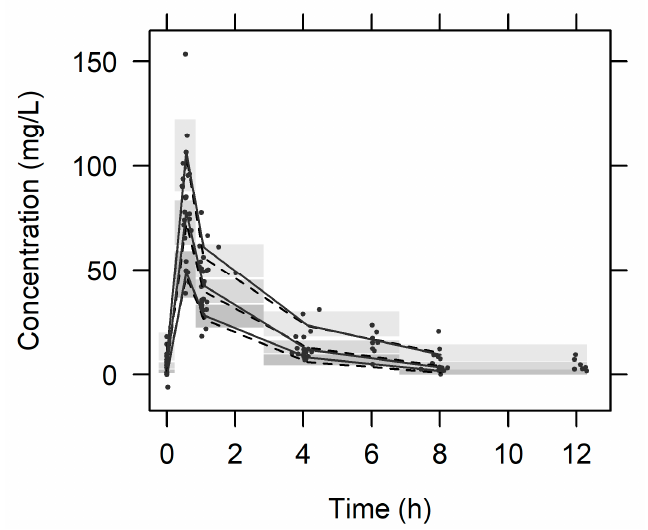
Figure 2. Visual predictive check plot. Plots from virtual concentrations of 1000 simulated datasets. Closed circles, observed serum meropenem concentrations; solid lines, the 10th, 50th, and 90th percentiles of observations; dashed lines, the 10th, 50th, and 90th percentiles of simulated serum meropenem concentrations; shaded areas, 95% confidence intervals for each percentiles of simulated concentrations.